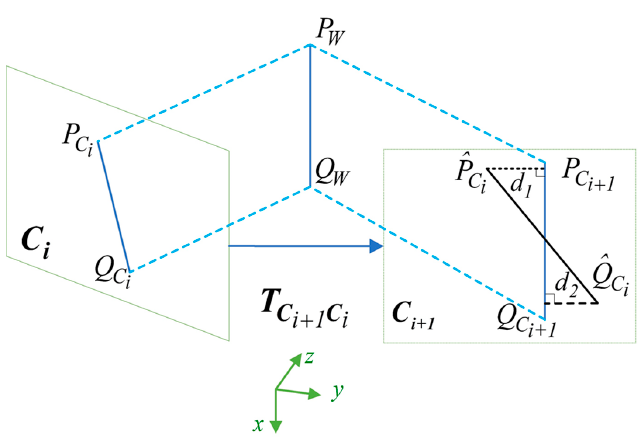
Figure 5. Interpretation of the line feature reprojection error.